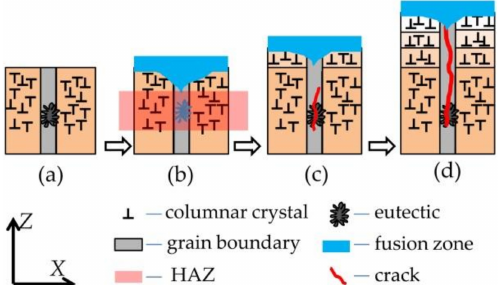
Figure 9. Schematic diagram of the formation process of liquation cracking, ( a ) a eutectic in a HAZ; ( b ) the liquefied eutectic; ( c ) the formation of a microcrack; ( d ) the extension of the